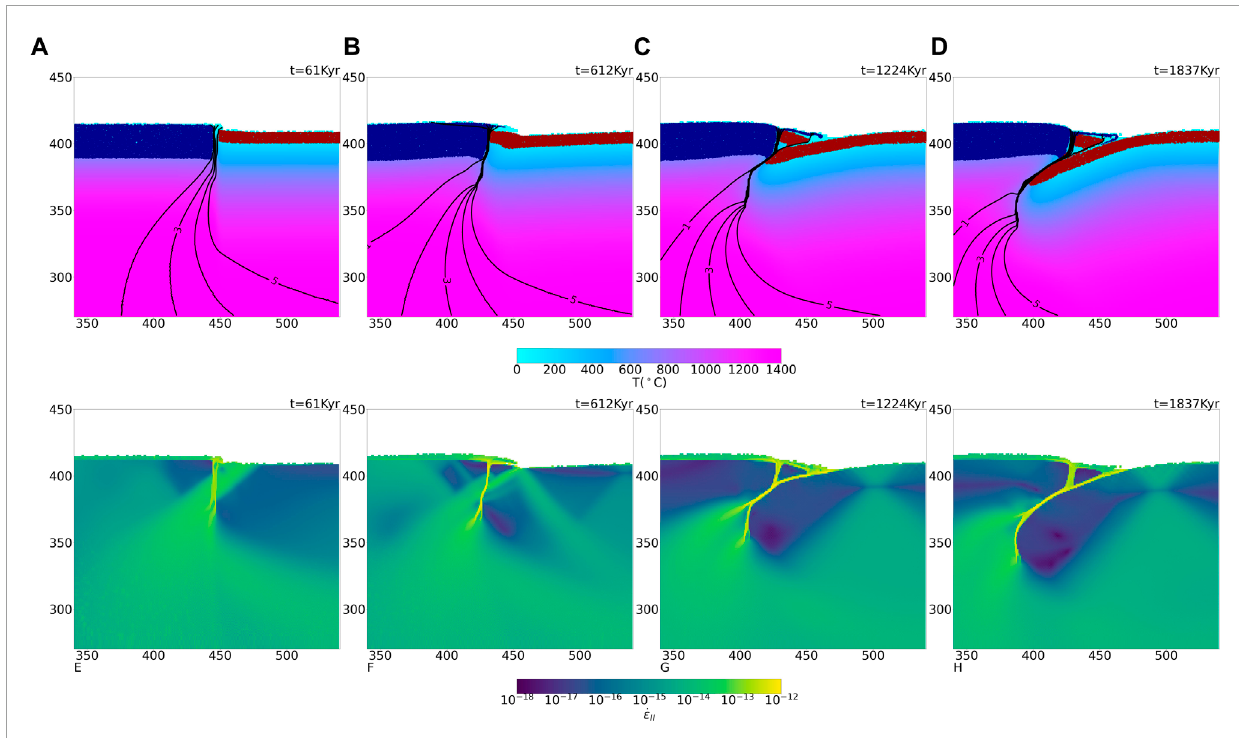
FIGURE 4 Fault evolution of a high resolution models with ( ɛ P 0 , V SS , V p ) = (2, 6 cm/yr, 4 cm/yr). (A–D) Red and blue for oceanic and continental crust. Background color for temperature. (E–H) Second invariant of strain rate ( ̇ ε II ) .